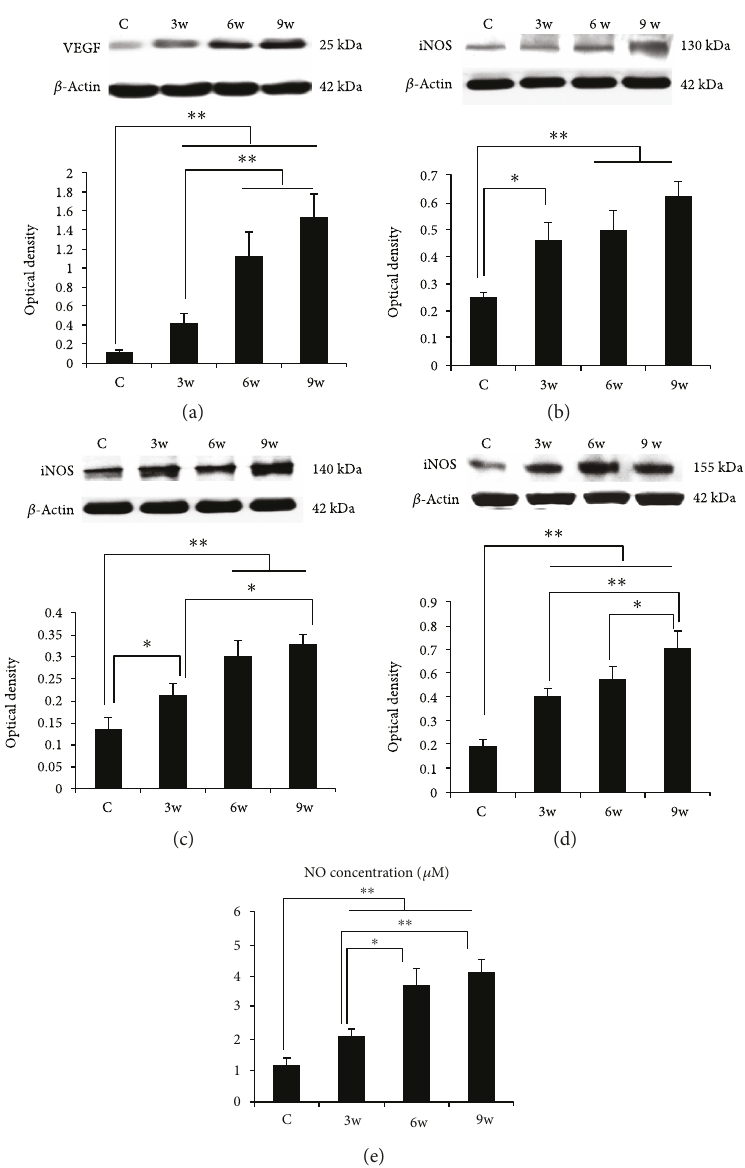
Figure 5: Western blot analysis of VEGF (a), iNOS (b), eNOS (c), and nNOS (d) protein expression levels in the retina in the NC, DM3w, DM6w, and DM9w groups, including the immunoreactive bands of VEGF (21 kDa), iNOS (130kDa), eNOS (140kDa), nNOS (155kDa), and β -actin (42 kDa). Bar graphs representing optical density (mean ± SD). The expression levels were all increased after diabetes induction. (e) NO concentration in the NC, DM3w, DM6w, and DM9w groups. NO concentration was signi fi cantly increased in the retina at 3w, 6w, and 9w after diabetes induction when compared with that of control rats. ∗ p < 0 05 and ∗∗ p < 0 01